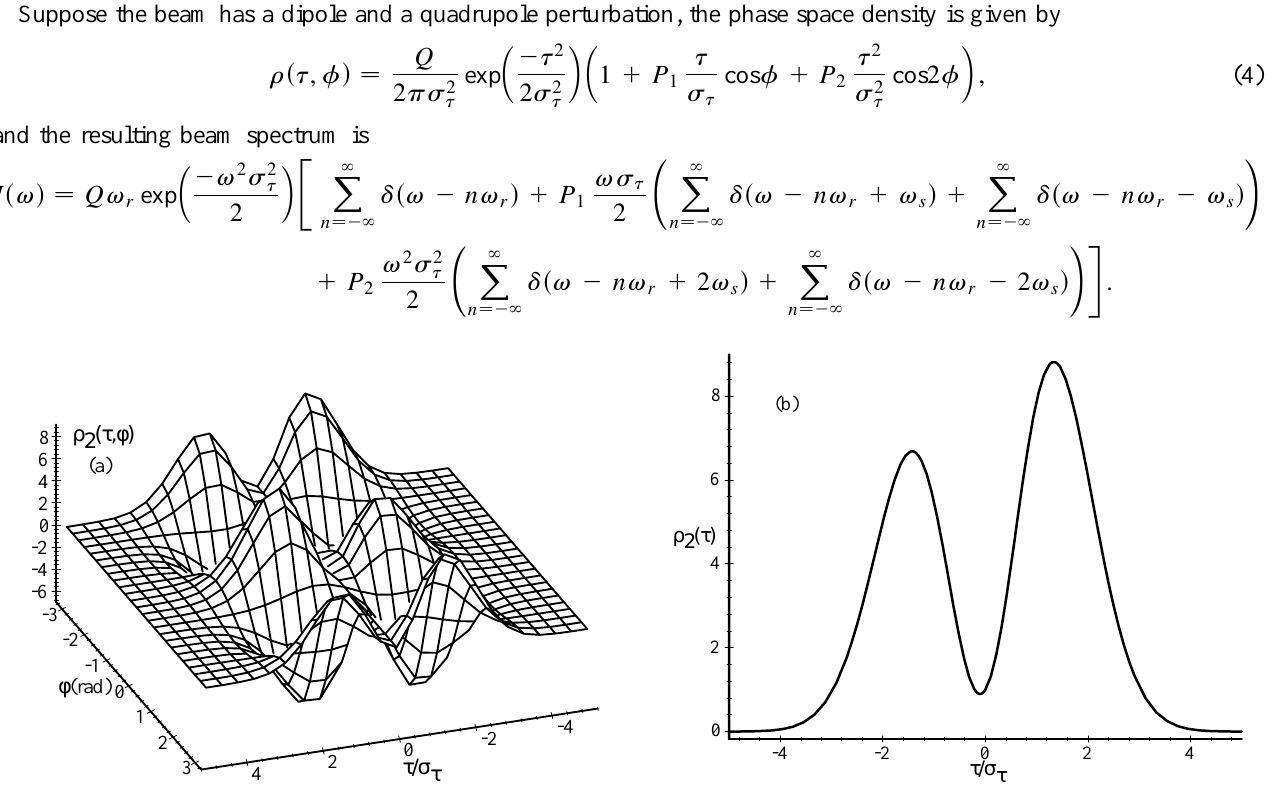
(cid:3) Q and the t